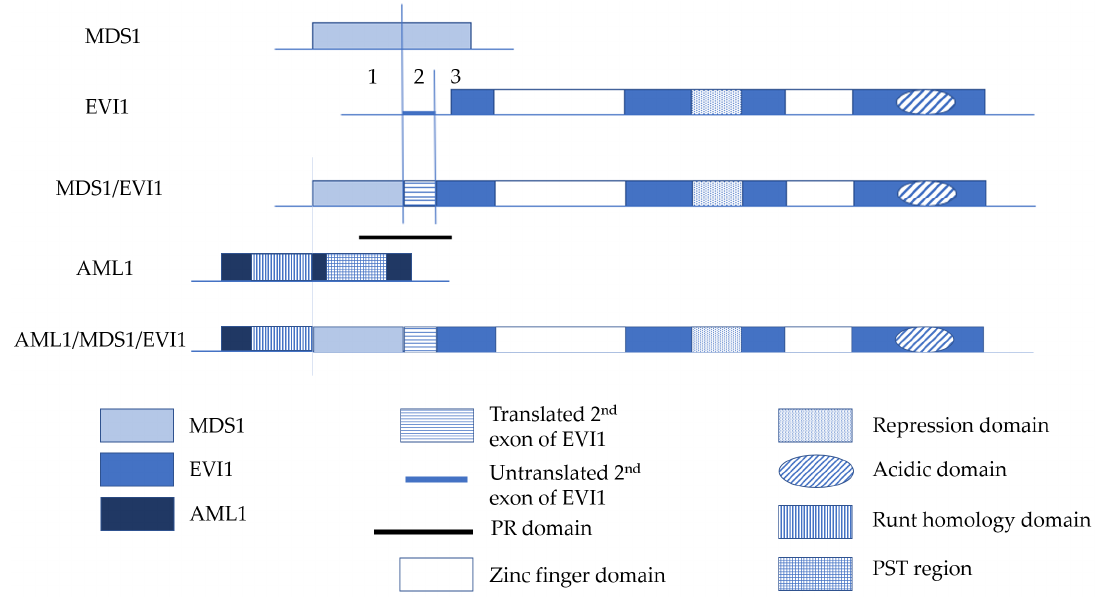
Figure 2. Diagram illustrating the relationship between EVI1, MDS1/EVI1 and AML1/MDS1/EVI1 . Untranslated regions are indicated by lines and reading frames are indicated by boxes. The vertical lines in MDS1/EVI1 indicate the junction with the 3′ alternative coding exon in MDS1, as well as the junctions between exon 1, 2 and 3 in EVI1. Numbers indicate EVI1 exons. The black thick line indicates the position of the PR domain. The vertical line in AML1/MDS1/EVI1 indicates the junction between AML1 and MDS1/EVI1, which is at the end of the runt homology domain.